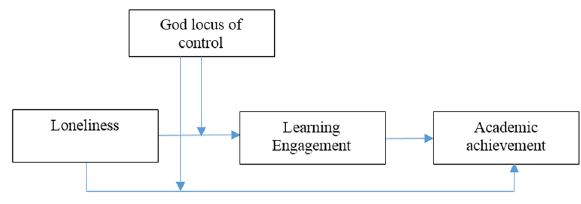
Fig. 1 Research model. A description of the relationship between variables in the present